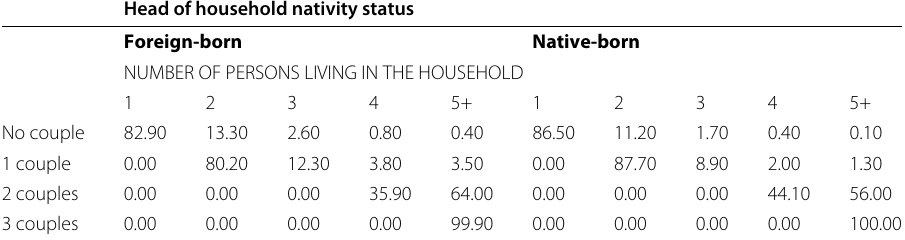
Table 19 Households distribution by number of couples and household size (nativity status) Head of household nativity